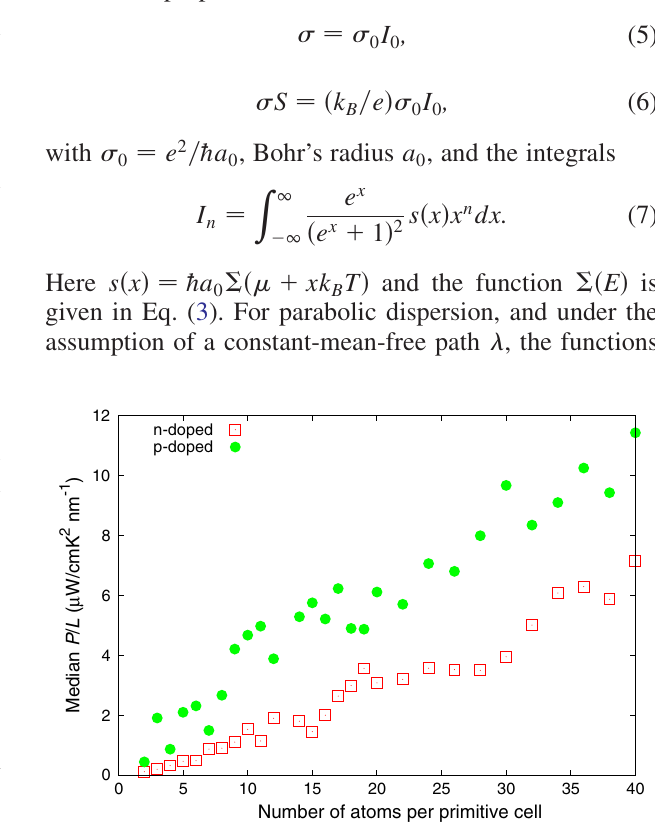
trend is depicted in Fig. 2 where the median of P=L is